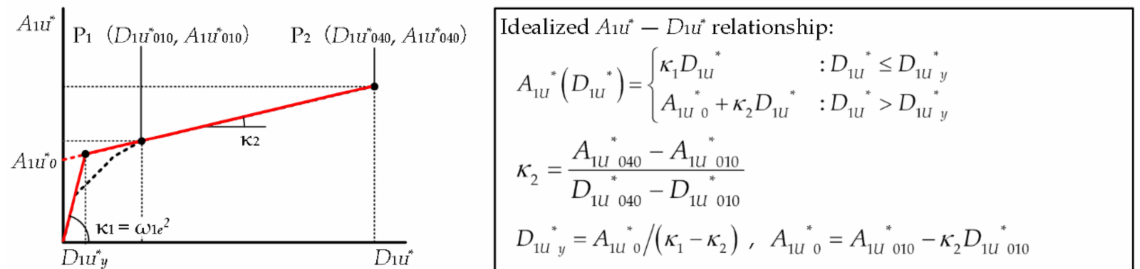
Figure 2. Bilinear idealization of the equivalent acceleration-equivalent displacement relationship.